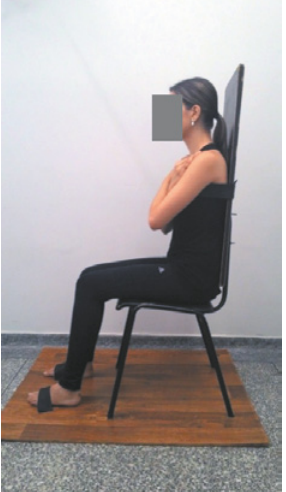
Figure 1. Chair adapted to the maximal isometric voluntary contrac- tion